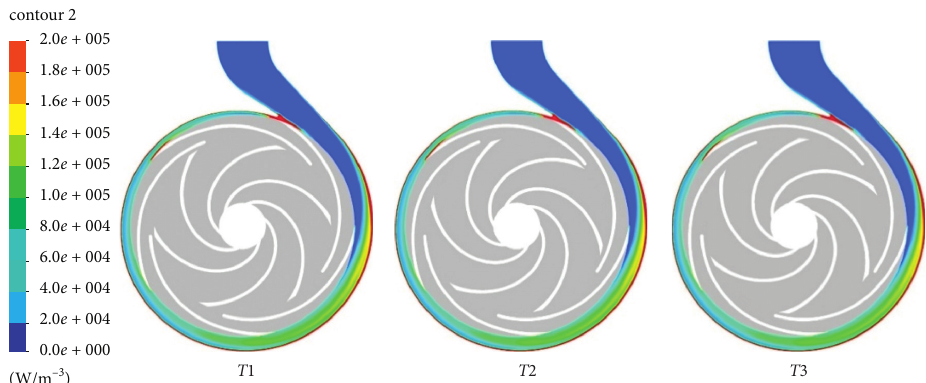
Figure 9: Entropy production rate in different moments in volute at 48m 3 /h.